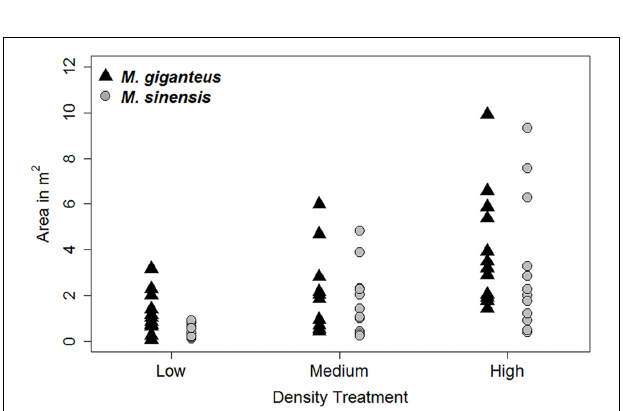
FIGURE 2 | Plot area (m 2 ) occupied by Miscanthus species, by Density treatment, in